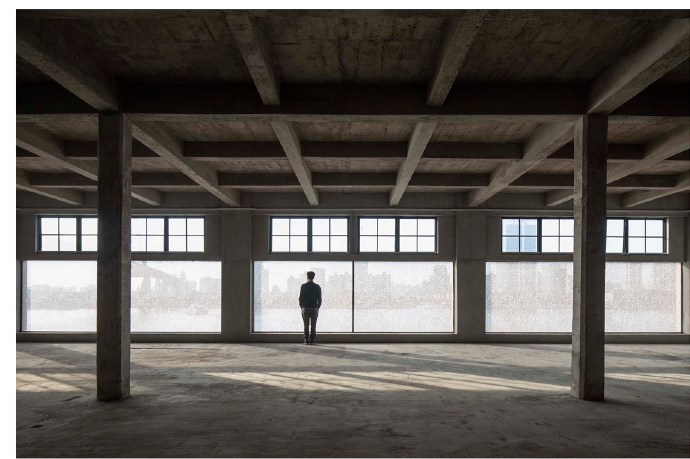
Fig. 11 Internal view of the façades made of screen-printed glass (Source: Fangfang